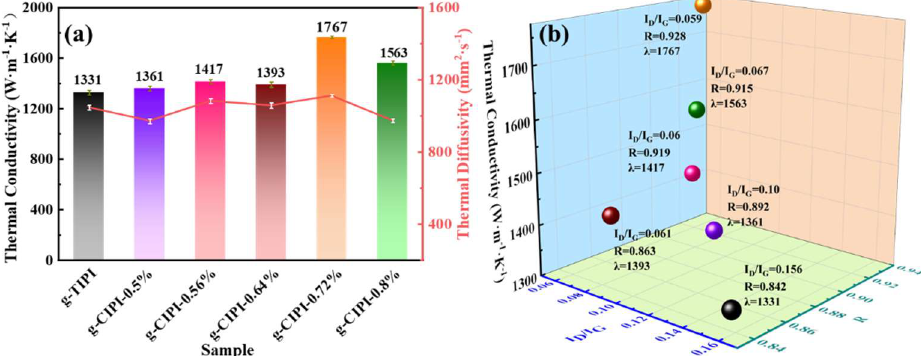
Figure 7. ( a ) The thermal properties measured of g-TIPI and g-CIPI-w films; ( b ) scatter diagram of thermal conductivity. Table 3. Comparison of thermal conductivities of graphite